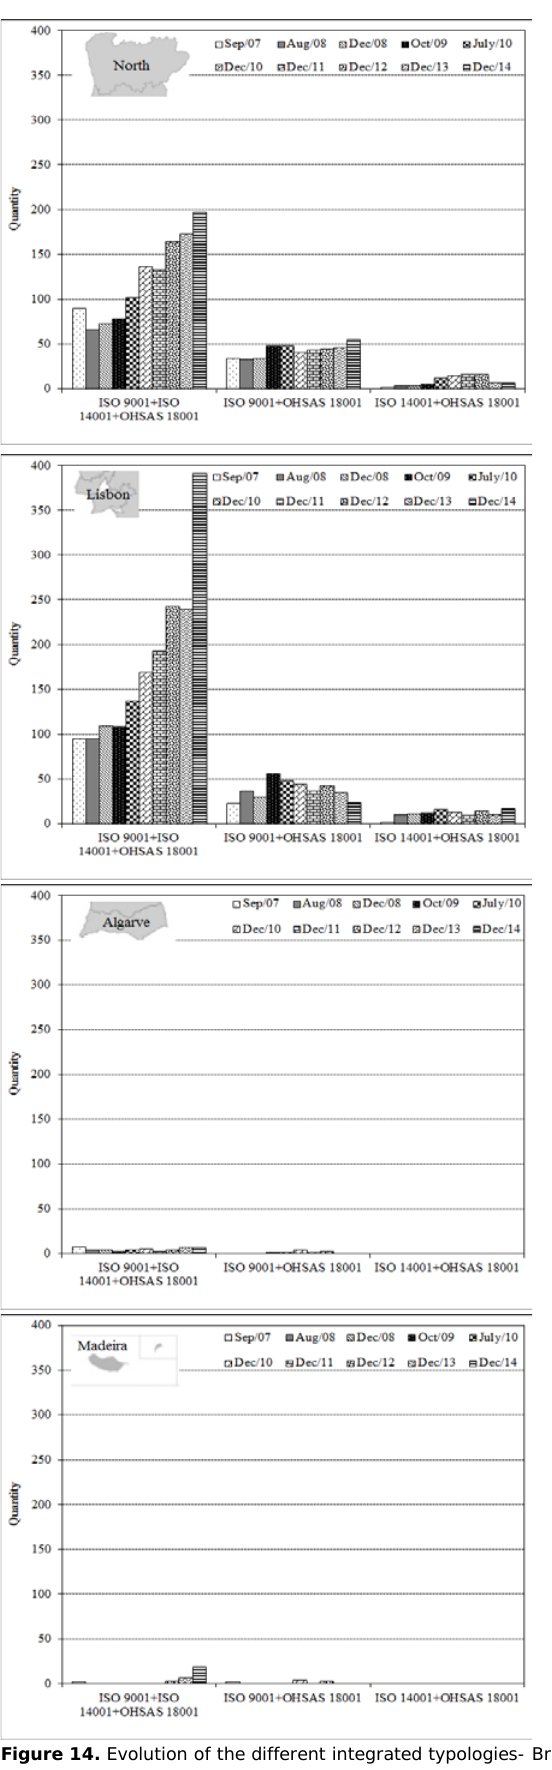
Figure 14. Evolution of the different integrated typologies- Breakdown by NUT II